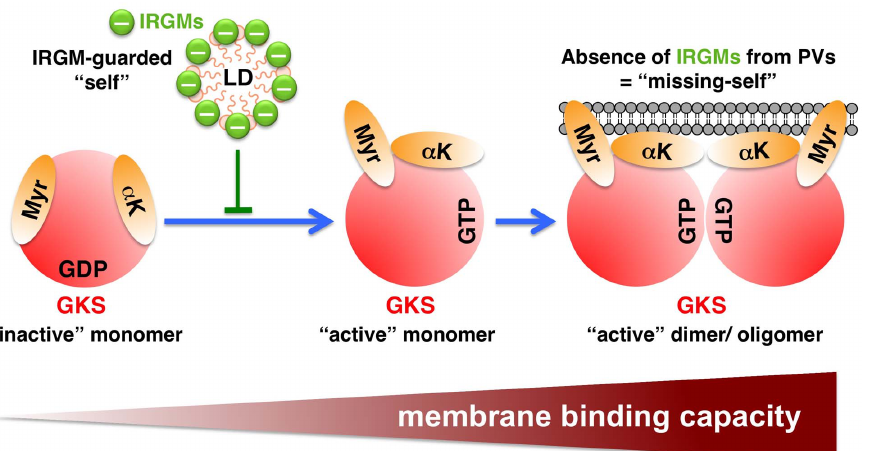
Figure 11. Proposed model: IRGM proteins regulate the localization of GKS and GBP proteins away from ‘‘self’’ membranes and towards ‘‘non-self’’ PVs. Upon GTP acquisition (=‘‘activation’’), GKS and GBP proteins transition into a conformational state that permits lipid binding. Protein oligomerization of activated GKS and GBP proteins further increases their membrane-binding activity and is critical for the stable association of GKS and GBP proteins with most membranes. IRGM proteins negatively regulate the ‘‘activation’’ and subsequent oligomerization of GKS and GBP proteins. Accordingly, IRGM-positive membranes/micelles (e.g. LDs) are protected against GKS and GBP binding and IRGM-free membranes (e.g. surrounding PVs) are targets for GKS and GBP binding. In addition to protecting self-structures, IRGM proteins also maintain a pool of inactive, monomeric GKS and GBP proteins. Monomeric GKS and GBP proteins are cytosolic and move around inside the cell until they encounter PVs. In Irgm1/m3 2 / 2 cells, the binding to IRGM-deficient endomembranes decreases the pool of available, monomeric GKS and GBP proteins and therefore diminishes the targeting of GKS and GBP proteins to PVs. In this illustration, the GKS protein Irgb10 with its two the putative lipid binding domains is given as an example (Myr=myristoyl group; a K=amphipathic